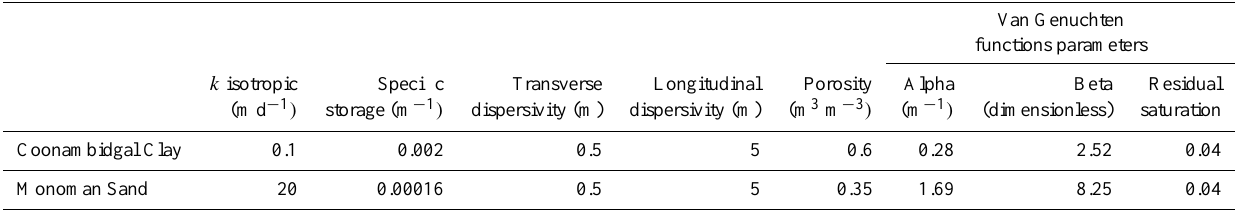
Table 1. Porous media and van Genuchten function parameter